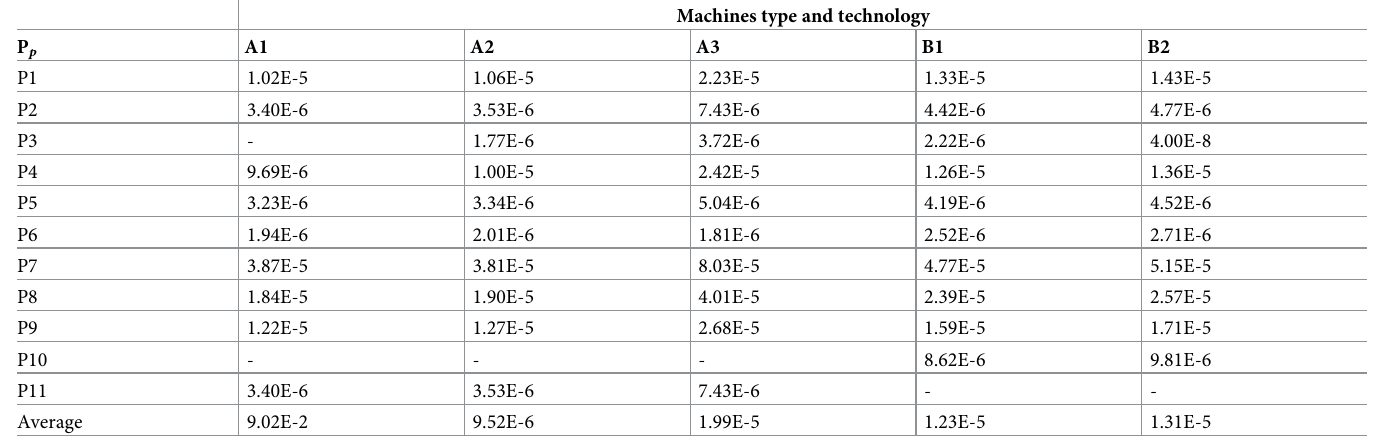
Table 10. Ratio between laser cutting speed and the equipment price, in m/min/$.